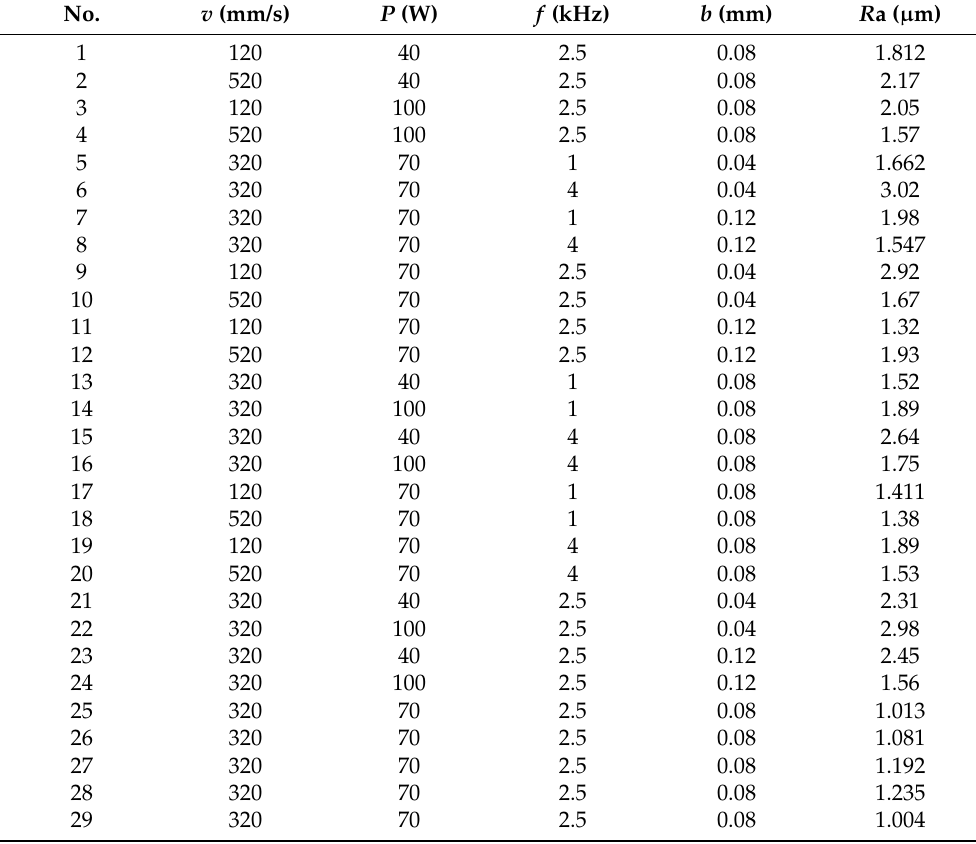
Table 3. Response surface experimental design and surface